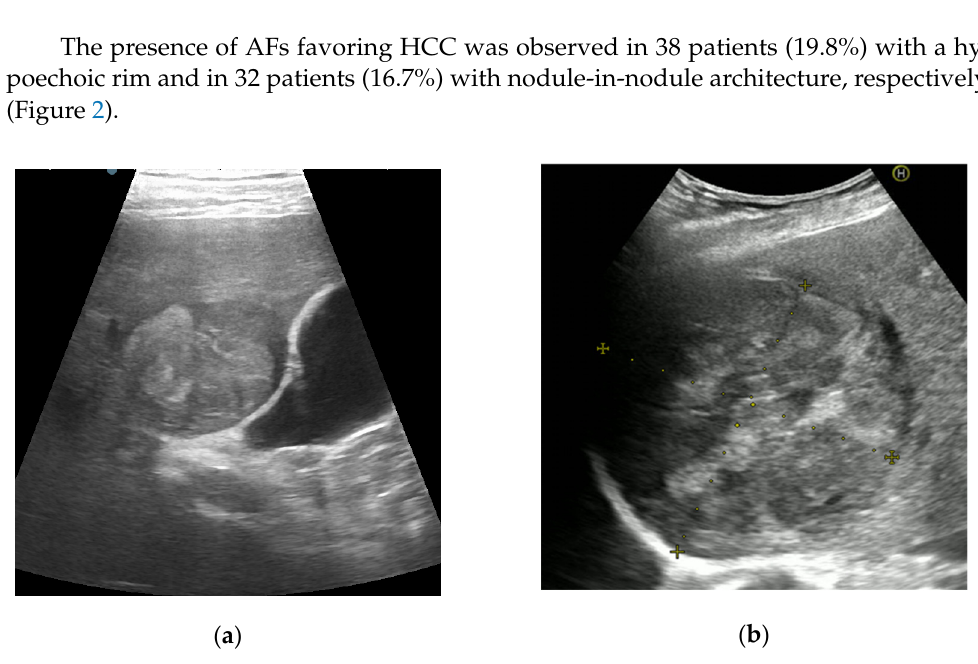
Figure 2. Illustrations of CEUS ancillary features in favor of HCC: nodule-in-nodule architecture ( a ) and mosaic architecture ( b ).